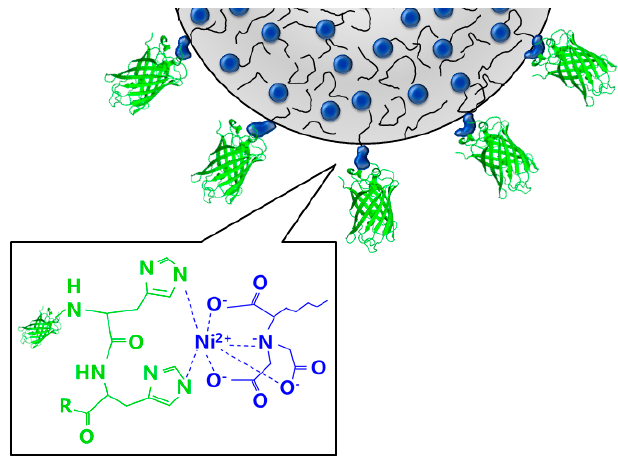
Figure 1. Configuration of the conjugation of the polymer and protein hybrid.